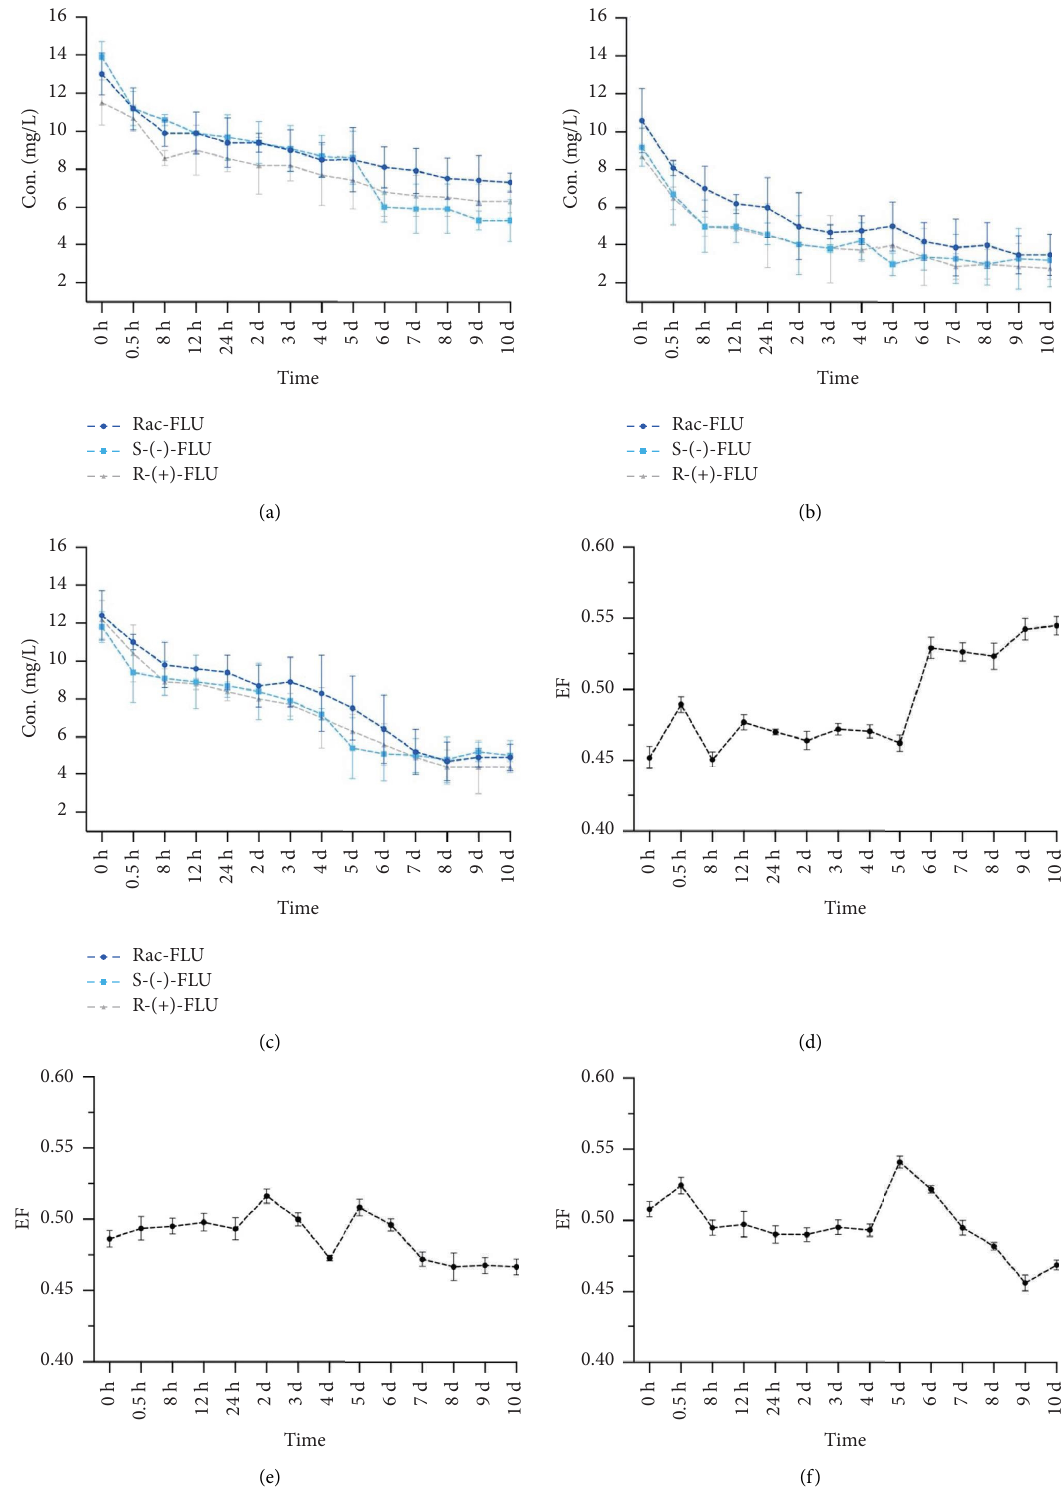
Figure 2: Adsorption curves in 1# (a), 2# (b), and 3# (c) and EF variation in 1# (d), 2# (e), and 3# (f) of FLU in three diferent sediments. Te points and error bars represent the mean and standard deviation of replicates, respectively ( n �